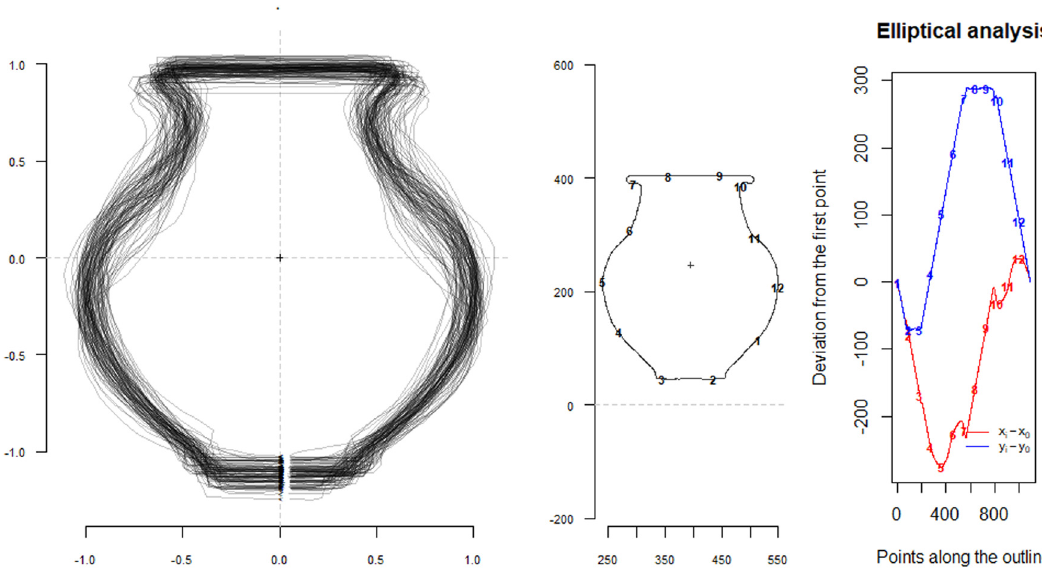
Figure 6: Left: 110 vessel outlines following coe ffi cient normalization. Right: oscilloscope for EFA approach, outlining the curves around outline drawing through the “ coo_oscillo ” function.